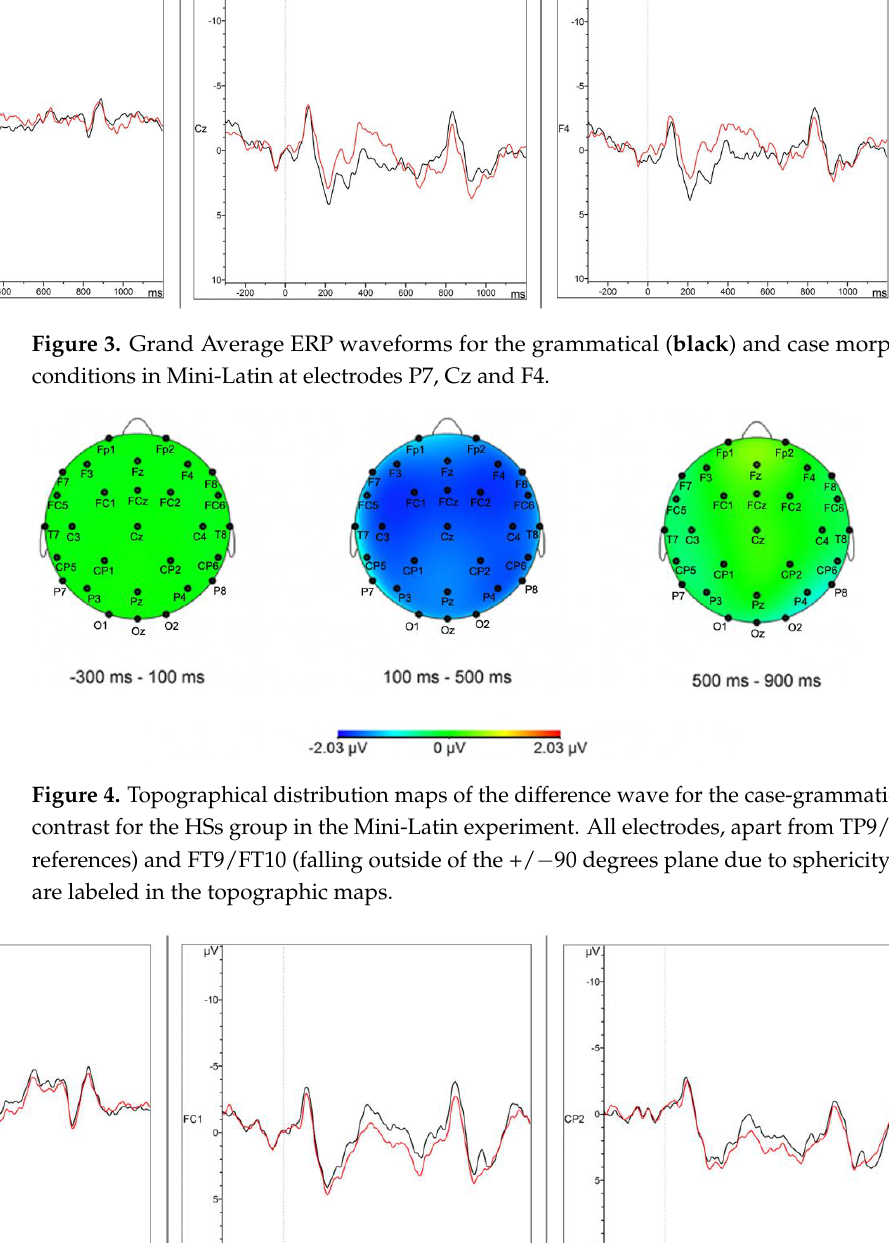
Figure 6. Topographical distribution maps of the difference wave for the adjective position-gram- matical condition contrast for the German L2 group in the Mini-Latin experiment. All electrodes, apart from TP9/TP10 (offline references) and FT9/FT10 (falling outside of the +/ − 90 degrees plane due to sphericity constraints), are labeled in the topographic maps.